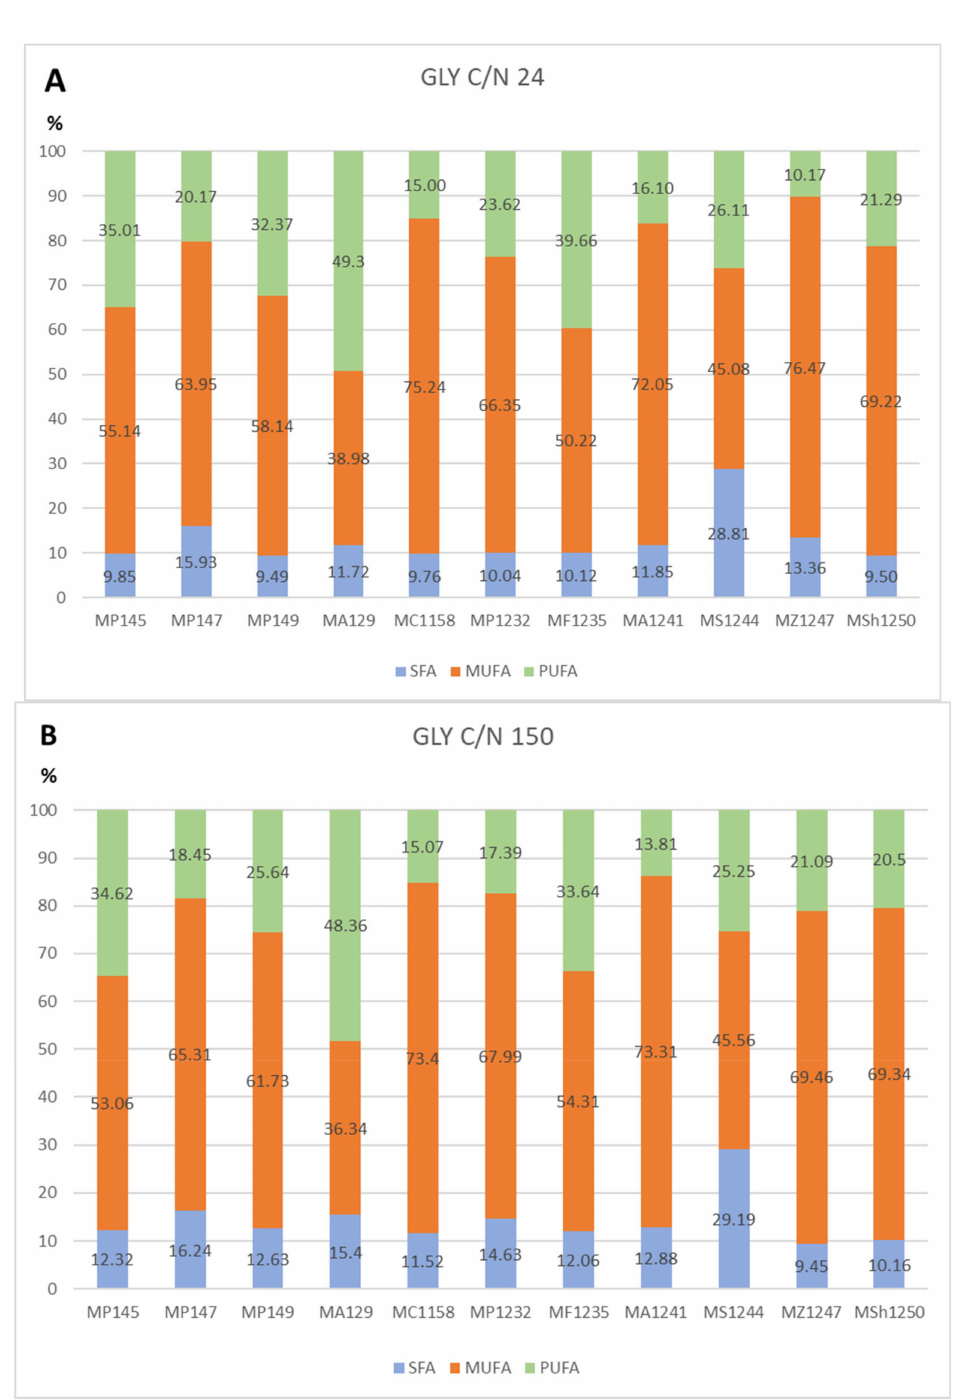
Figure 4. Percentage of fatty acids of yeasts on glycerol medium with C/N ratios 24 ( A ) and 150 ( B ). Legends: Metschnikowia pulcherrima 145 (MP145), Metschnikowia pulcherrima 147